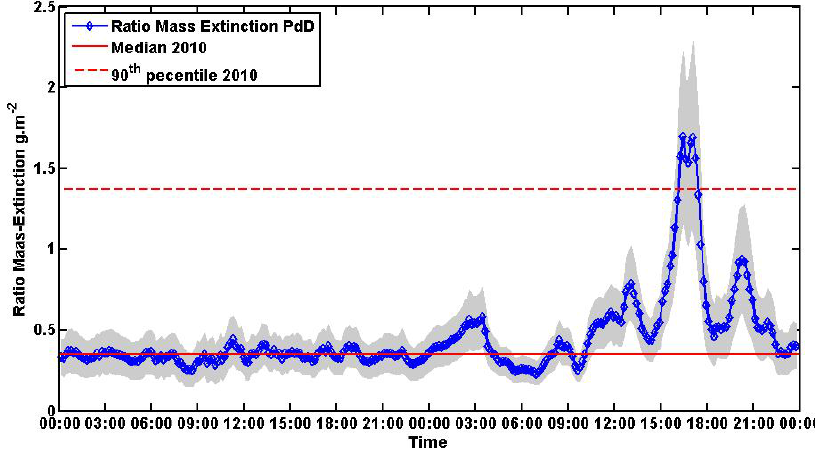
Fig. 5. Mass extinction ratio η calculated at 355nm for the 18 to 19 May 2010. The continuous red line represents the median and the dashed red line the 90th percentile calculated using all data for the year